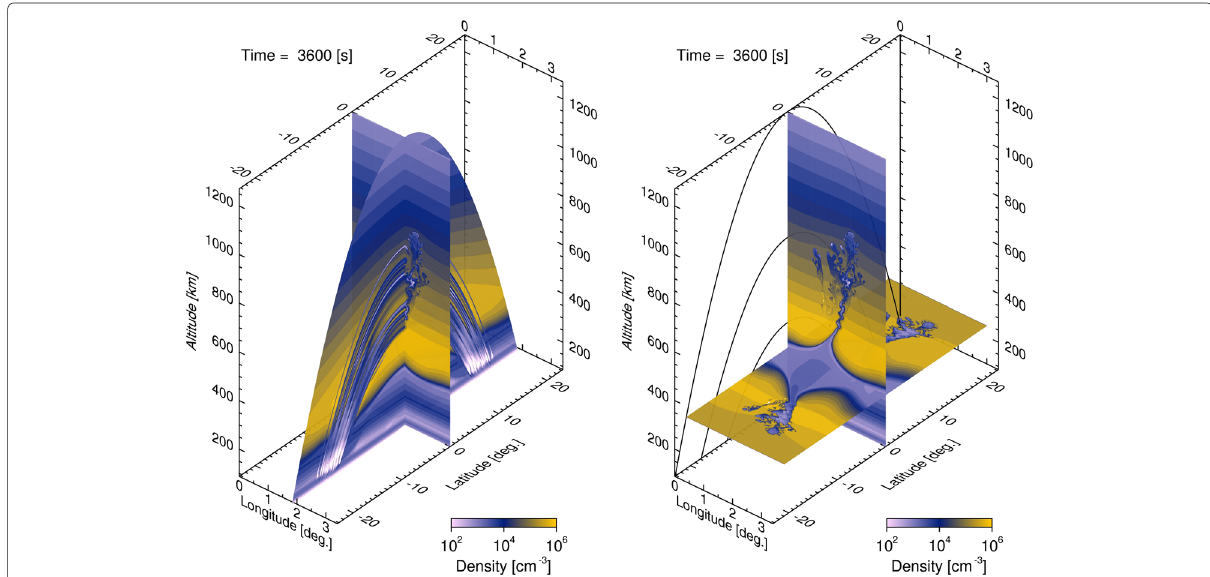
Fig. 1 Perspective view of the EPB simulation environment. The left frame shows the central meridian plane. The right frame shows the structure in two orthogonal slice